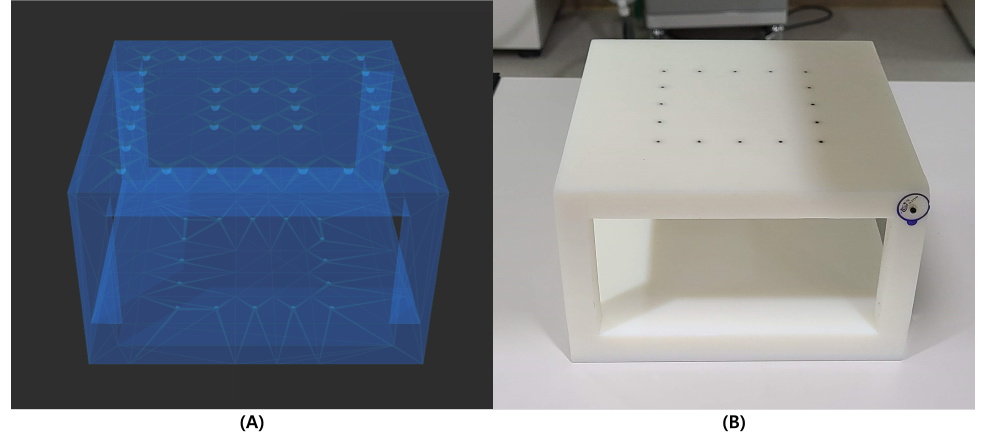
Figure 1. Calibration phantom model ( A ) was designed using CAD software, and the phantom ( B ) was built with a 3D printer, with lead-bearing fiducial markers to establish precise locations.